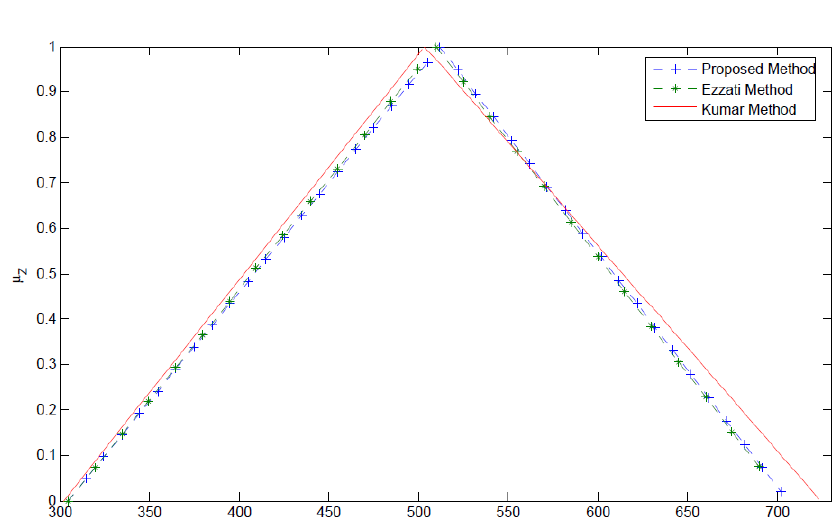
Figure 2. Membership function: Proposed method vs existing methods. Table 1. Data of Example 4.4 (in U. S.